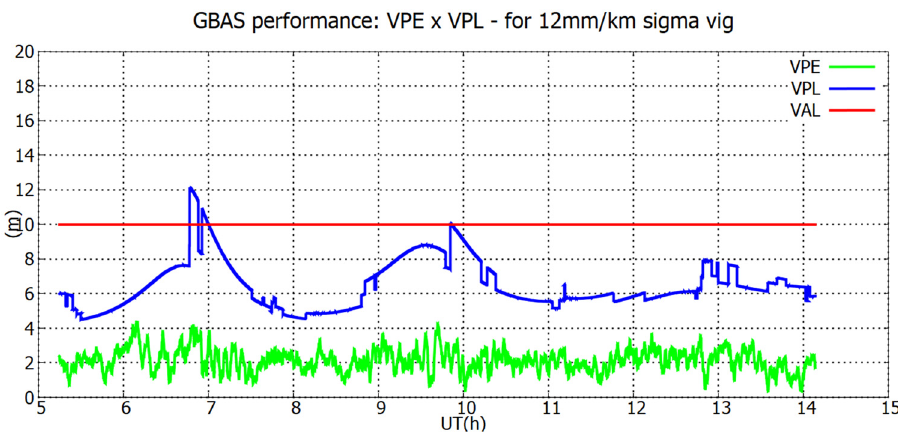
Figure 12: Performance of positioning errors and protection levels for GBAS simulation considering σ vig of 12 mm/km.